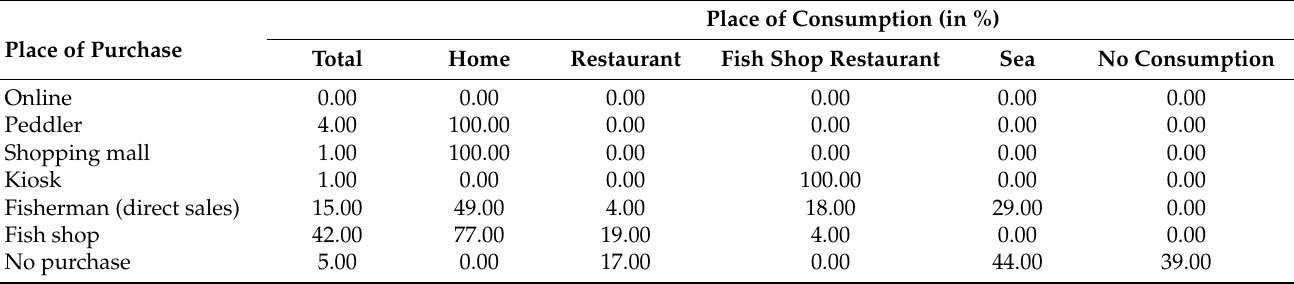
Table 4. Purchase sites by consumption place of sea urchin (in % of respondents), excluding restau- rants (conventional restaurant and restaurant-fish, representing together more than 30%).